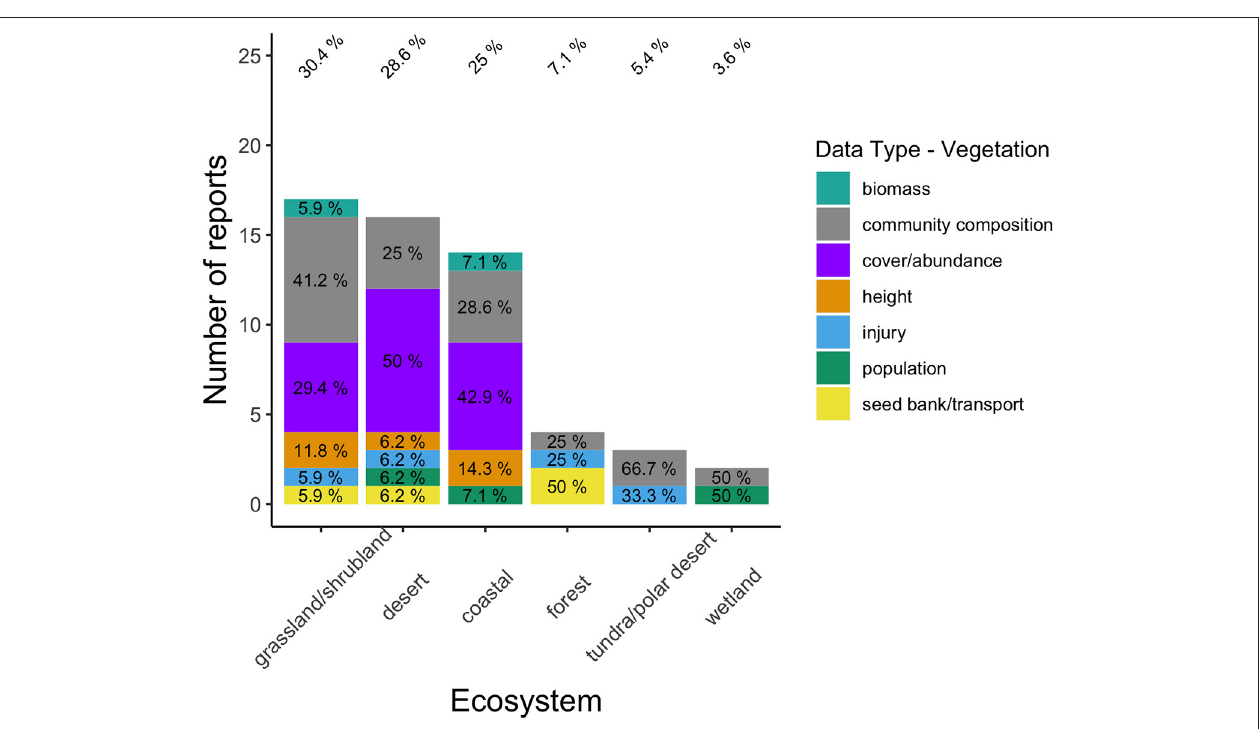
( n = 1; 7.1%). In forest habitats ( n = 4), studies measured seed bank/transport ( n = 2), community composition ( n = 1), and shrub injury ( n = 1). The three studies found